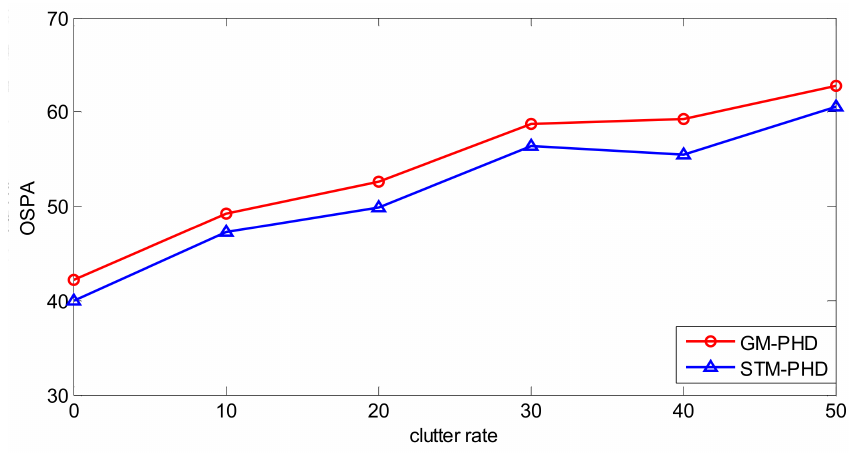
Figure 13. Comparison of OSPA distance of two filters with different clutter rates.